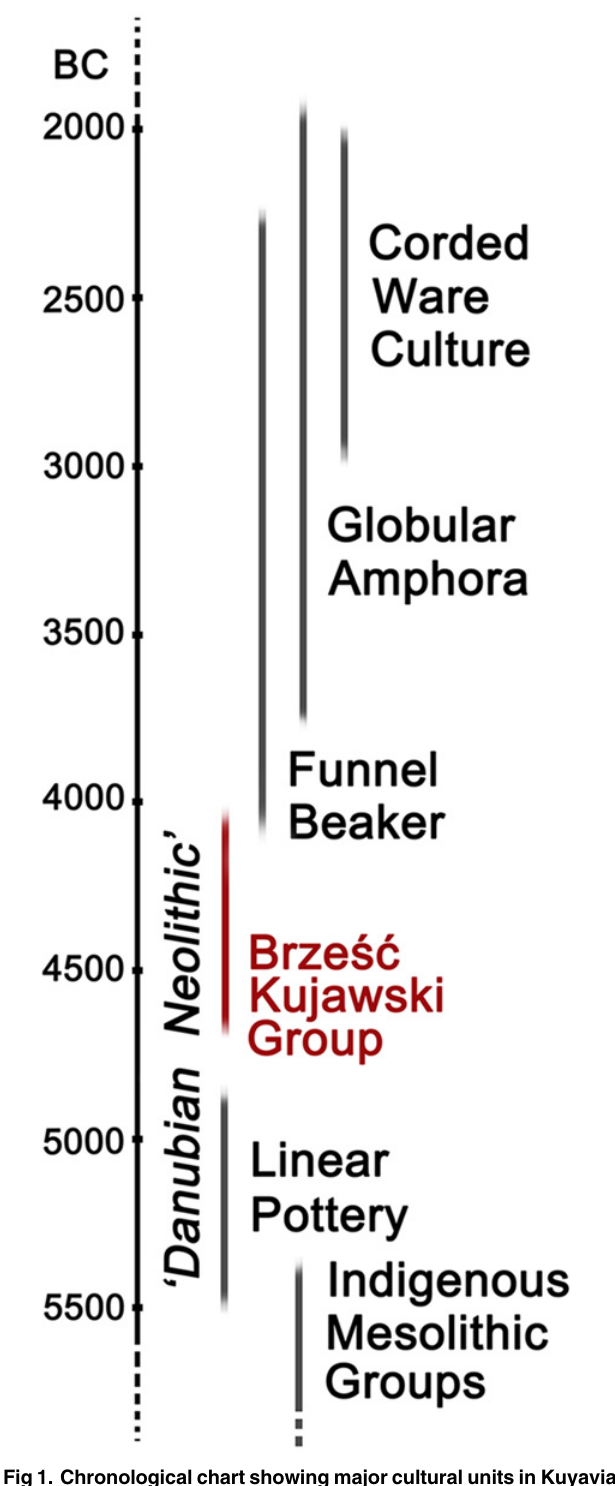
Fig 1. Chronological chart showing major cultural units in Kuyavia region in the period between 5500 and 2000 BC (after: [28, 53]).